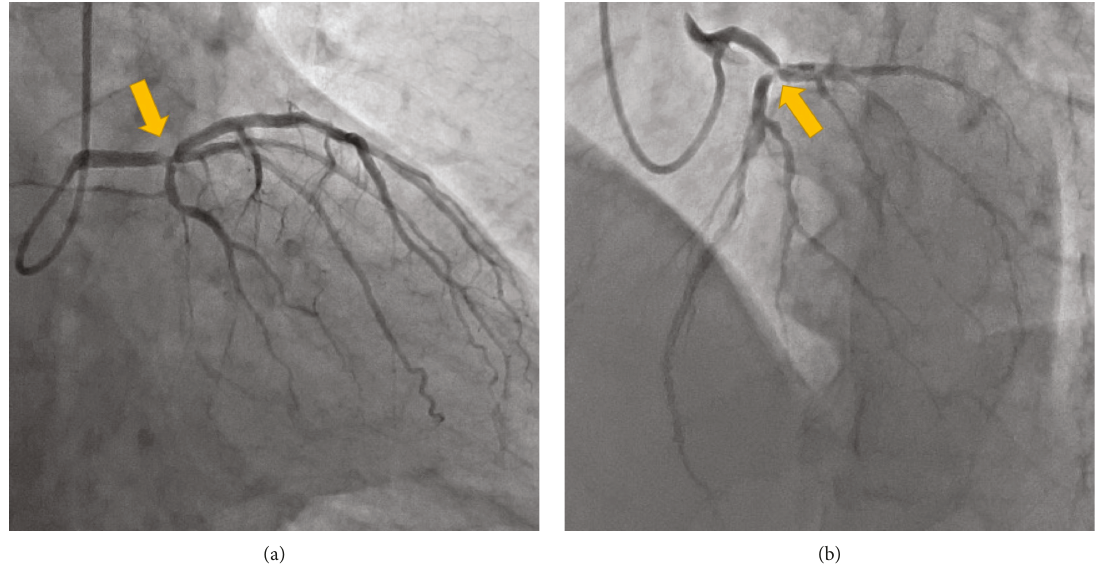
Figure 1: Left coronary angiogram of the (a) right anterior oblique caudal view and (b) left anterior oblique cranial view revealed a signi fi cant distal left main trifurcation lesion (yellow